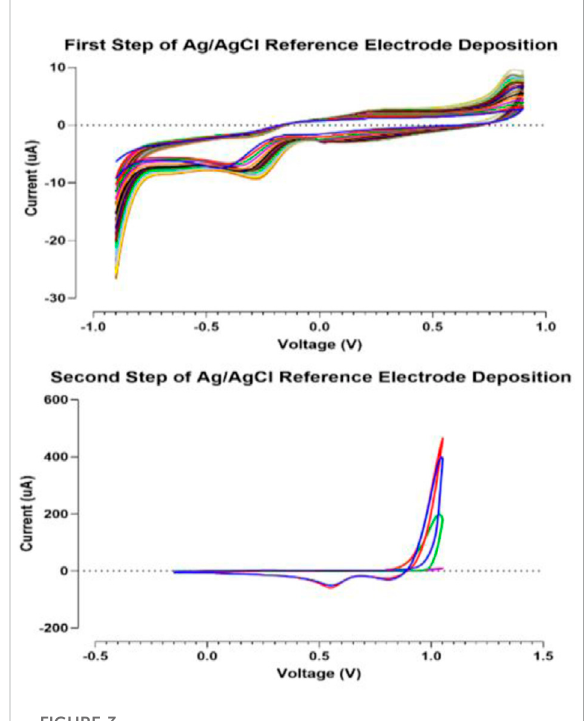
FIGURE 3 Voltammograms of Ag/AgCl reference electrode fabrication steps.